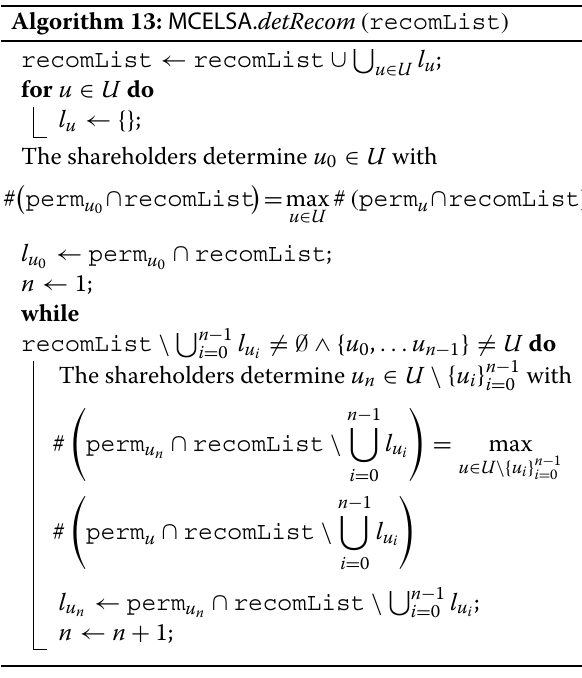
Algorithm 13: MCELSA . detRecom ( recomList